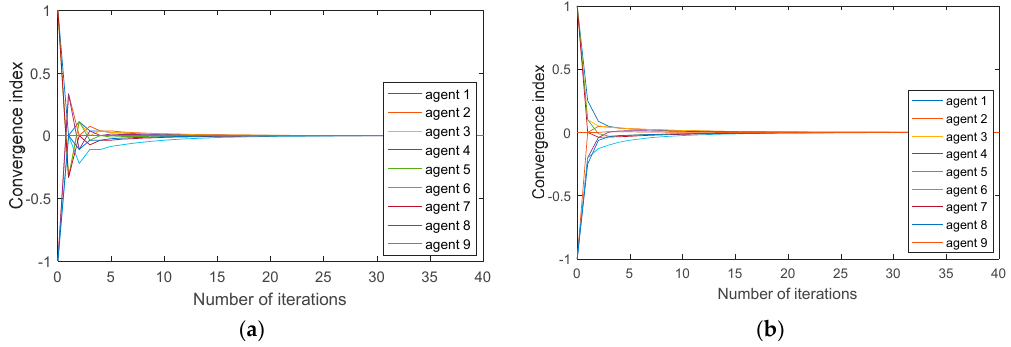
Figure 12. The convergence speed of the different topologies of Figure 11: ( a ) topology a; ( b ) topology b.